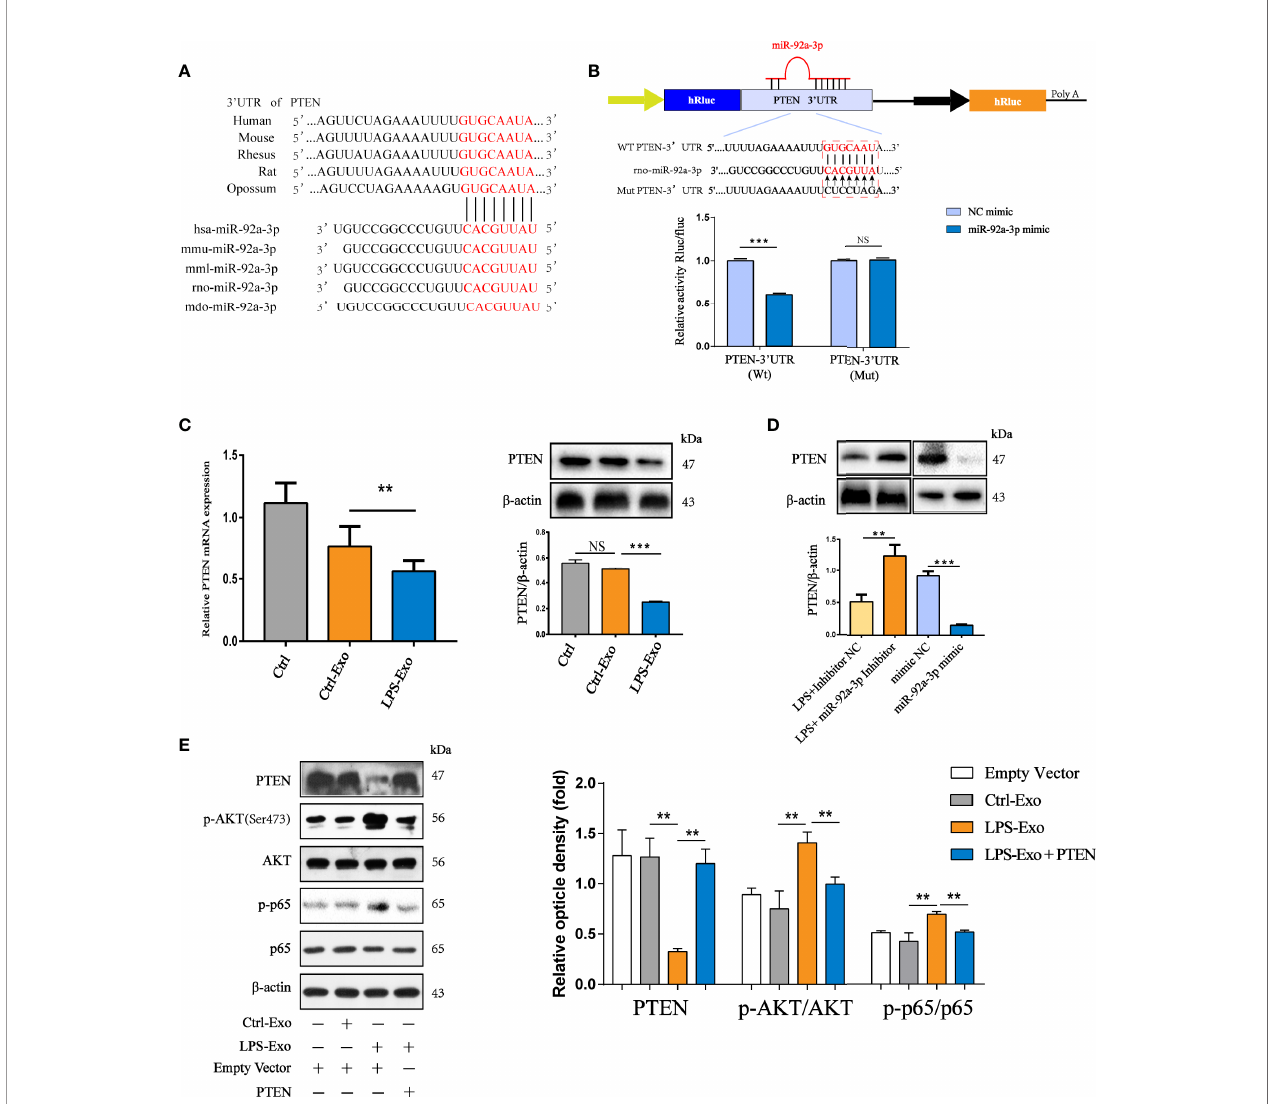
FIGURE 6 | Exosomal miR-92a-3p activates alveolar macrophages via PTEN. (A) Conservation of the miR-92a-3p target sequence in the PTEN 3 ’ UTR among different species and conservation of the miR-92a-3p sequence among different species. (B) The dual-luciferase reporter assay was performed in 293T cells. Cells were cotransfected with the wild-type or mutant PTEN 3 ’ UTR luciferase reporter plasmids, as well as miR-92a-3p mimic or NC mimic. (C) mRNA and protein expression of PTEN in recipient alveolar macrophages treated with AEC-Exo were examined by RT-PCR and western blot analysis. (D) The protein levels of PTEN were detected using western blot analysis after transfection with miR-92a-3p inhibitor or miR-92a-3p mimic. b -actin was used as an internal control. (E) Immunoblot of lysates from AMs overexpressing PTEN in the presence or absence of LPS-Exos. The rescue of PTEN expression dramatically inhibited LPS-Exo induced p65 phosphorylation and tended to decrease these levels in response to LPS-Exos. b -actin was used as an internal control. Data are presented as the mean ± S.E.M. **P<0.01, ***P<0.001 compared between two groups. NS, no signi fi cant difference, n=3 per